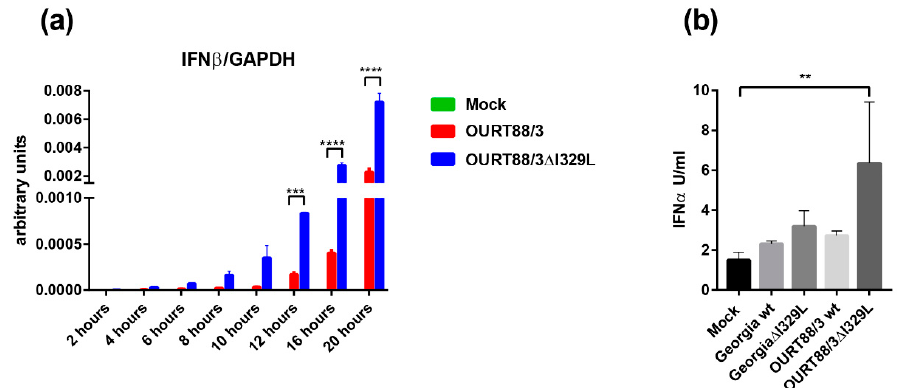
Figure 3. Expression of type I interferon (IFN) in macrophages infected with wild-type and I329L deletion mutants. Panel ( a ) shows IFN- β transcripts relative to GAPDH. Pig alveolar macrophages (PAMs) were mock infected or infected with wild-type OURT88 / 3 or OURT88 / 3 ∆ 329L viruses at an multiplicity of infection (MOI) of 1. At di ff erent times post-infection (x-axis), RNA was extracted and copy numbers for IFN- β and GADPH were quantified by quantitative real time PCR (qPCR) (y-axis). Panel ( b ) shows IFN- α detected in supernatants from porcine bone marrow cell cultures infected with wild-type or I329L gene-deleted ASFV isolates. PBM cells were mock infected or infected with wild-type Georgia or OURT88 / 3 isolates and I329L gene deletions from these viruses as indicated on the x-axis at an MOI of 1. At 16 h, post-infection levels of IFN- α were assayed and are shown as units per / mL on the y axis. The results shown are averages from infections of cells from 3 di ff erent outbred pigs. Asterisks indicate statistically significant di ff erences between the indicated samples (** p ≤ 0.01; *** p ≤ 0.001; **** p ≤